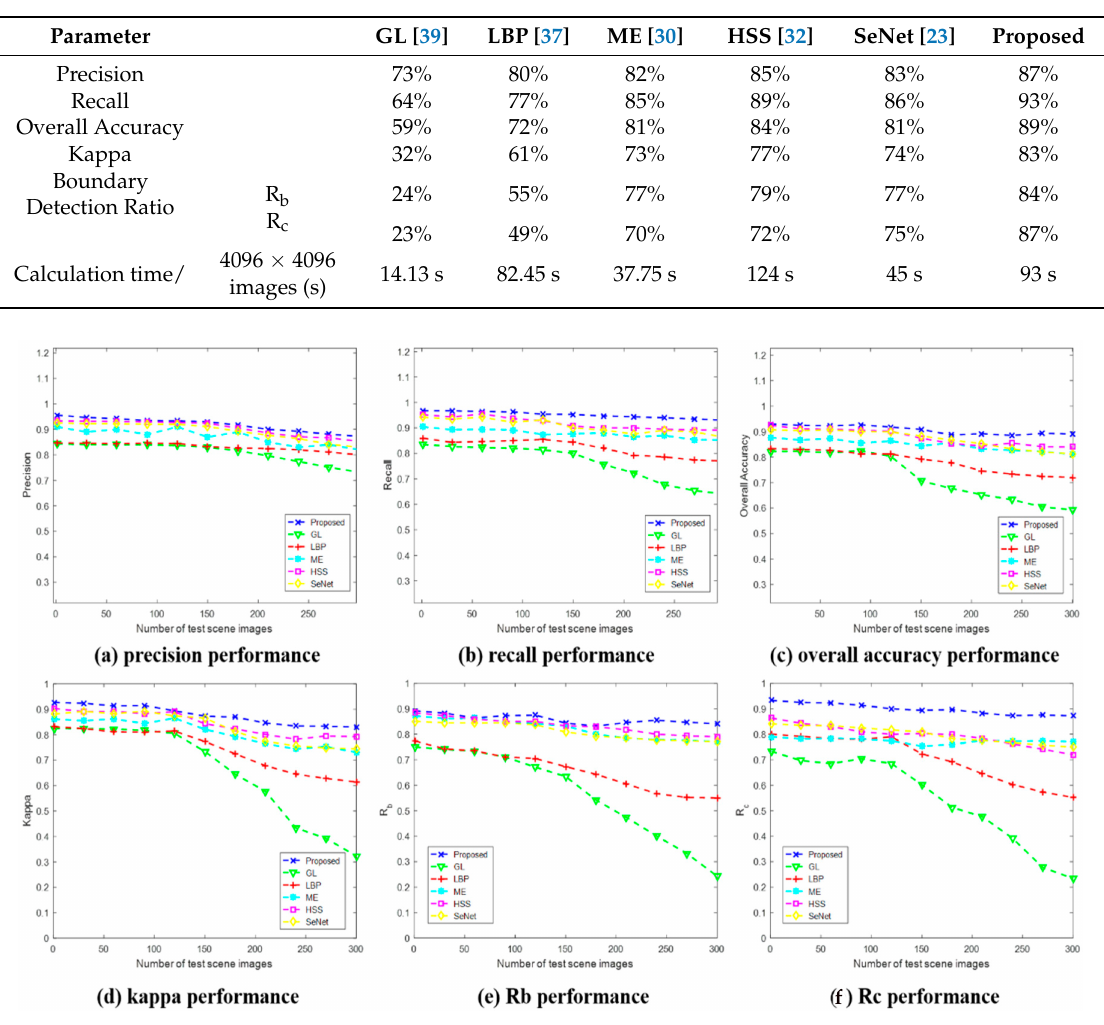
Figure 11. Performance comparison analysis based on selected dataset. ( a ) is precision performance of selected dataset, ( b ) is recall performance of selected dataset, ( c ) is overall accuracy performance of selected dataset, ( d ) is precision performance of selected dataset, ( e ) is R b performance of selected dataset, ( f ) is R c performance of selected